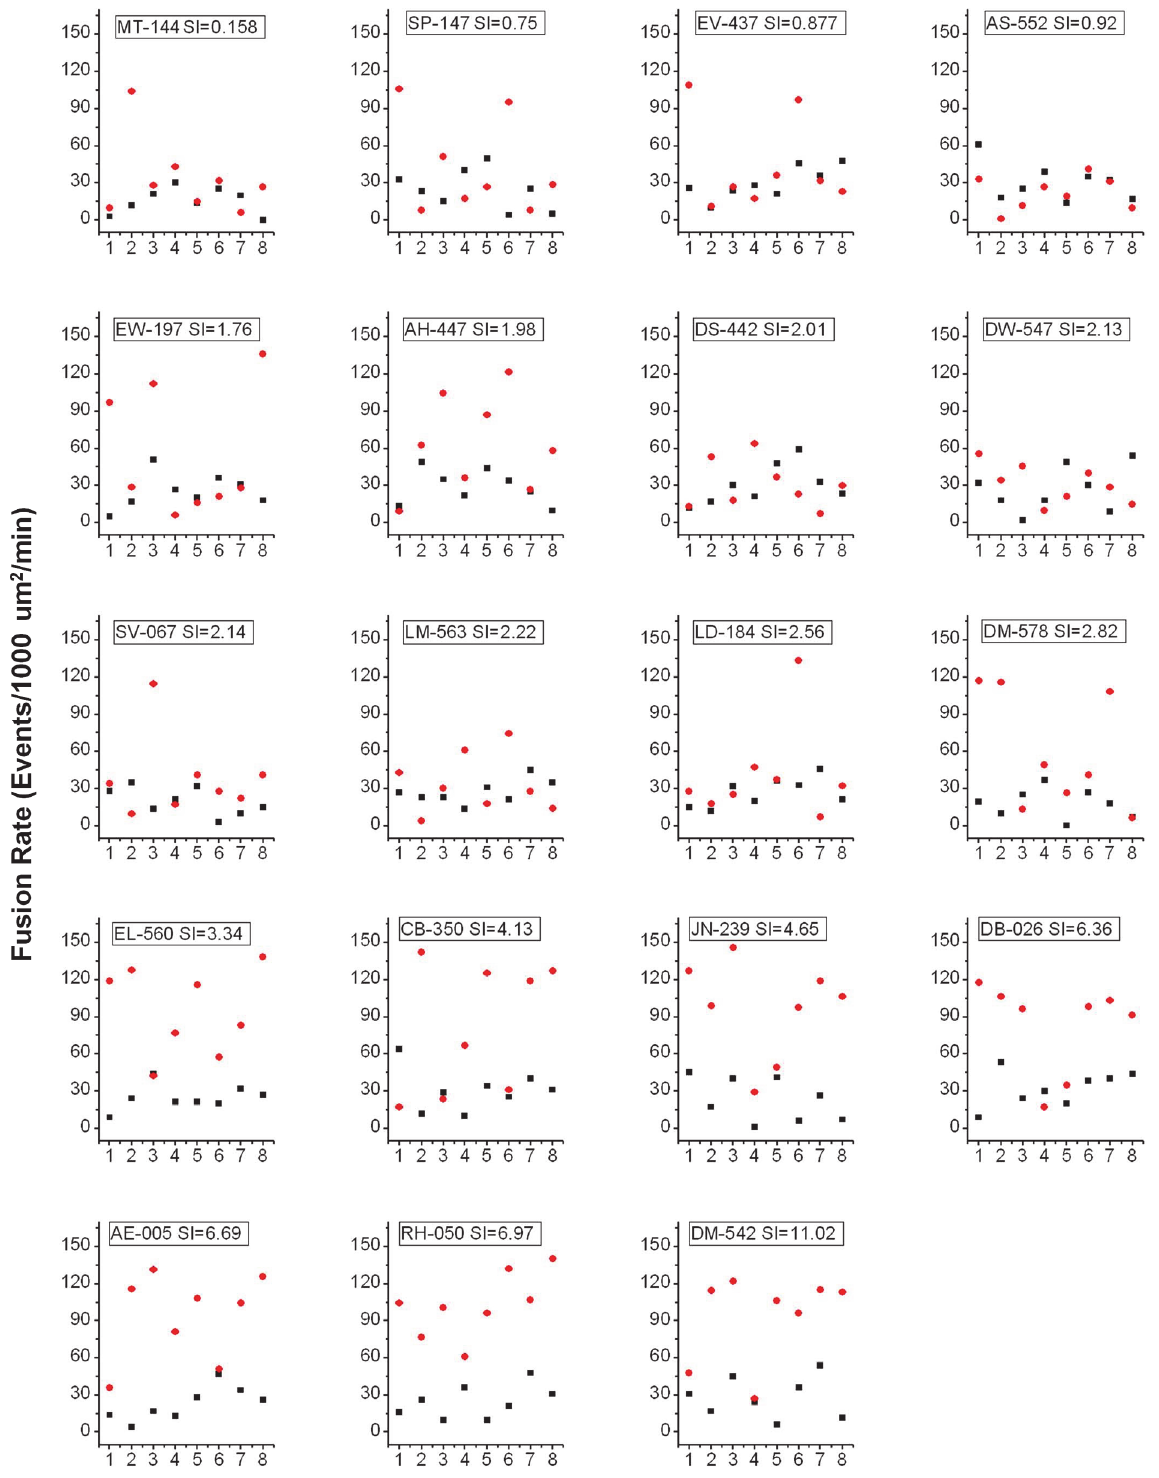
Fig 3. Fusion rate in the basal (black) and insulin-treated (red) states measured in individual cell and plotted for each subject. X axis corresponds to the sequential order in which cells were imaged for each subject. Y axis represents GSV fusion rate measured as the number fusion events detected with IRAP-pHluorin per 1000 μ